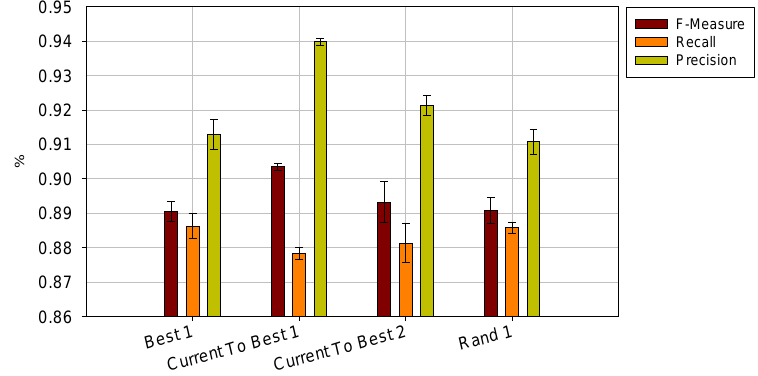
Figure 8. The evaluation of the proposed method with different mutation schemes with respect to the ground truth (manually marked) with its respective standard deviations (after 10 trials in each set